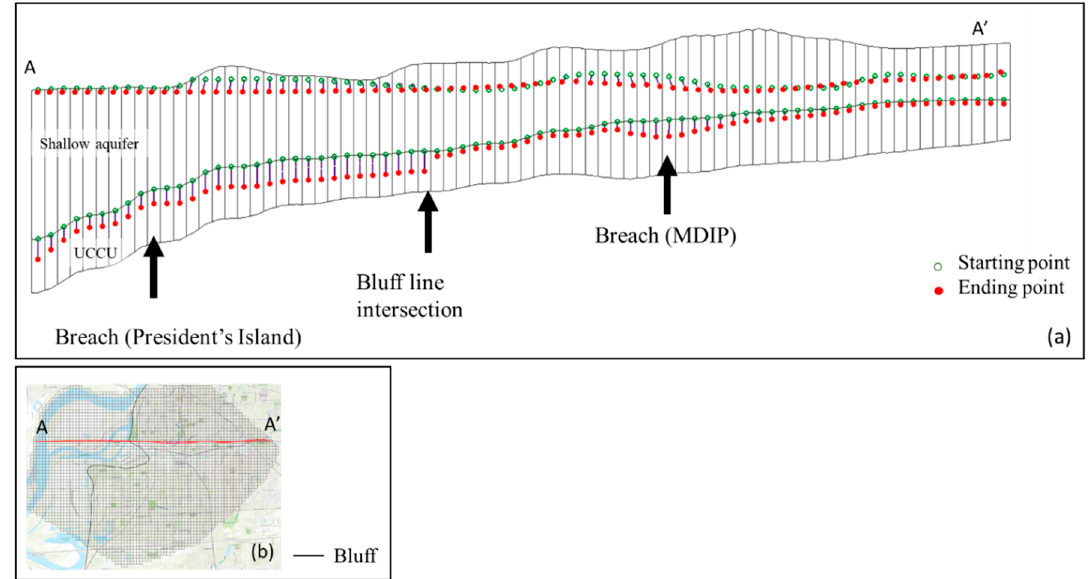
Figure 12. The A–A’ cross section of the Shallow aquifer, and the UCCU used for particle tracking. ( a ) shows the Shallow aquifer and the UCCU at the cross section. ( b ) shows the plan view of the cross section. Particles are placed on top of the groundwater in the shallow aquifer, and on top of the UCCU in 2005 (Green mark). Forward particle tracking shows the transport of the particles within the layers (blue line), and the position of each particle at the end of simulation in 2015 (Red mark).